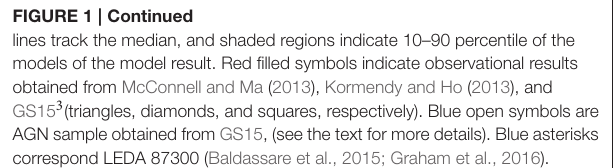
FIGURE 1 | Continued lines track the median, and shaded regions indicate 10–90 percentile of the models of the model result. Red filled symbols indicate observational results obtained from McConnell and Ma (2013), Kormendy and Ho (2013), and GS15 3 (triangles, diamonds, and squares, respectively). Blue open symbols are AGN sample obtained from GS15, (see the text for more details). Blue asterisks correspond LEDA 87300 (Baldassare et al., 2015; Graham et al., 2016).